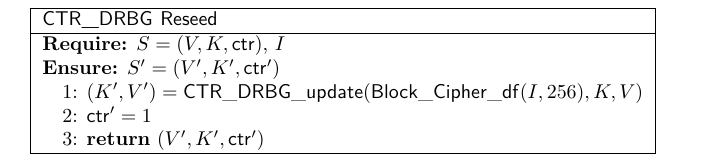
Figure 30: NIST CTR _ DRBG Reseed